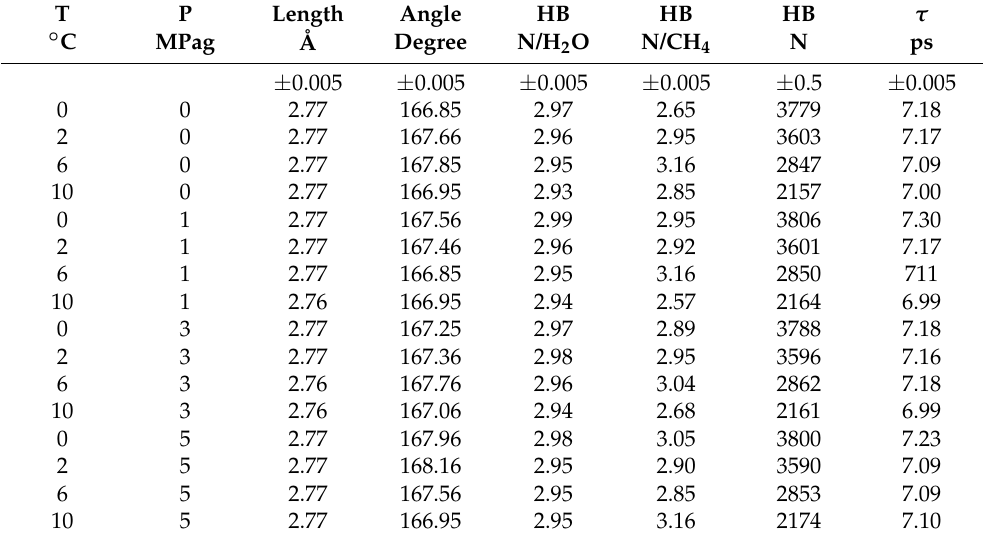
Table 6. Bond lengths and angles from a Gaussian kernel density estimation, the average number of hydrogen bonds (HBs) per hydrogen donor available (H 2 O and CH 4 ), and time constants ( τ ) from